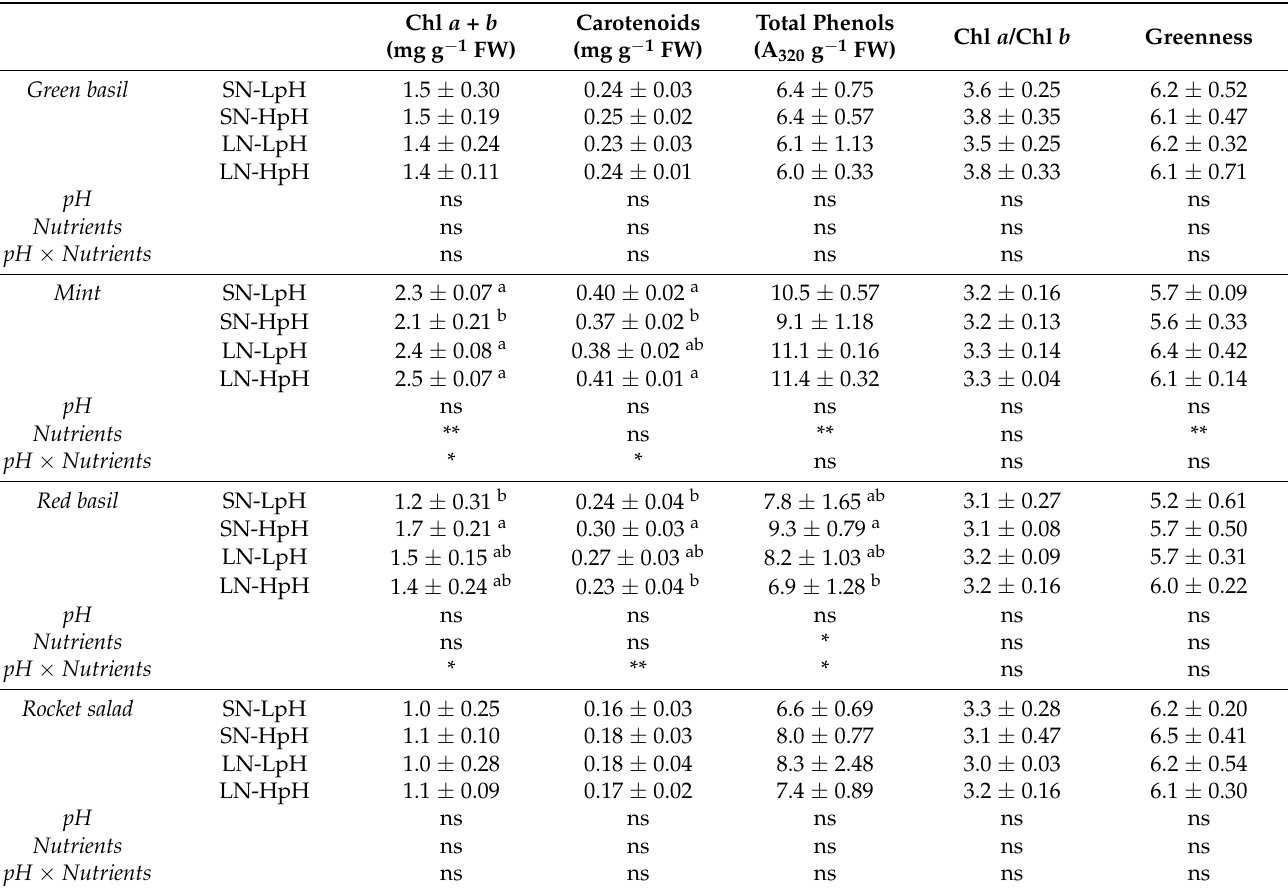
Table 3. Chlorophyll a + b , carotenoids, total phenols, chlorophyll a / b , and greenness of green basil, mint, red basil, and rocket